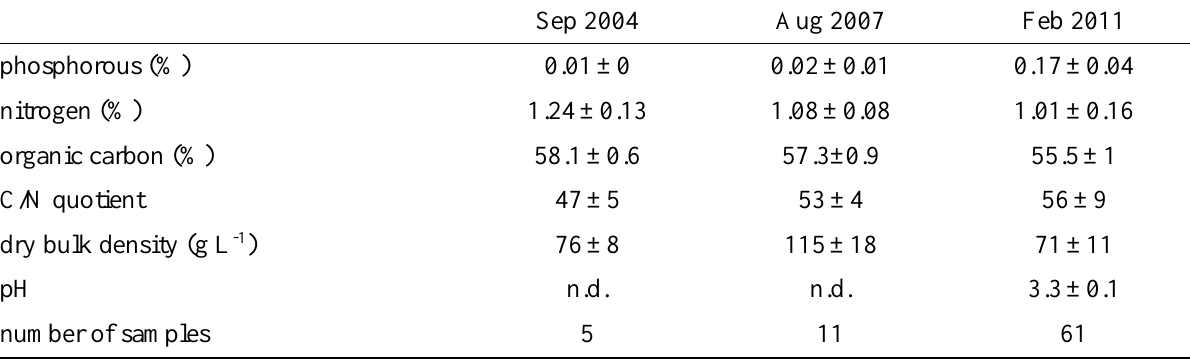
Table 1. Characterisation of the ‘black peat’ of the Ramsloh site over the duration of the study (mean value ± SD). Data from September 2004 derived from Kamermann & Blankenburg (2008). n.d. = data not